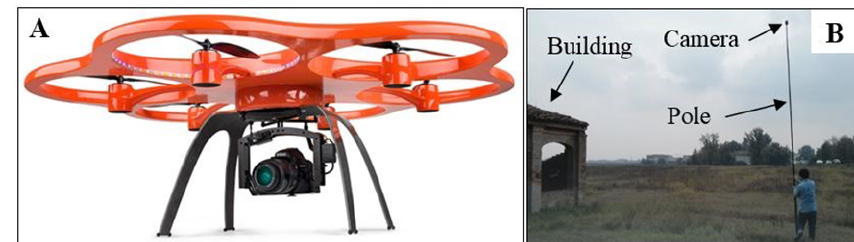
Figure 2. The two platforms used to collect data. (a) Aibot X6 V1 UAV, (b) camera attached to a